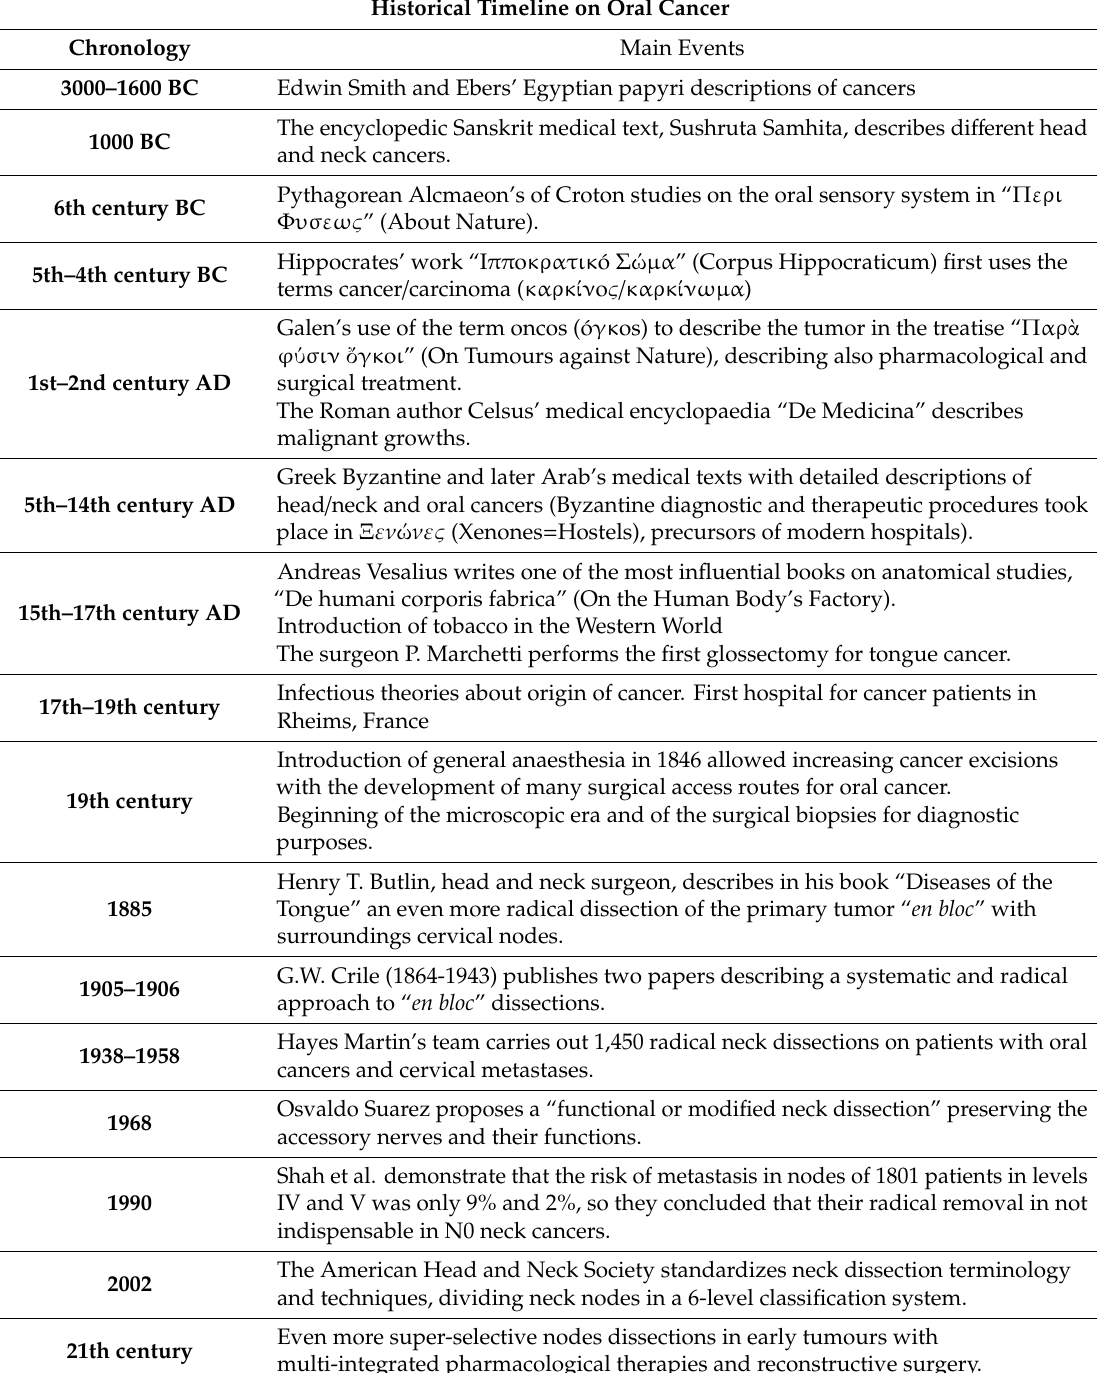
Table 1. Overview of the main steps of the knowledge about oral cancer and its